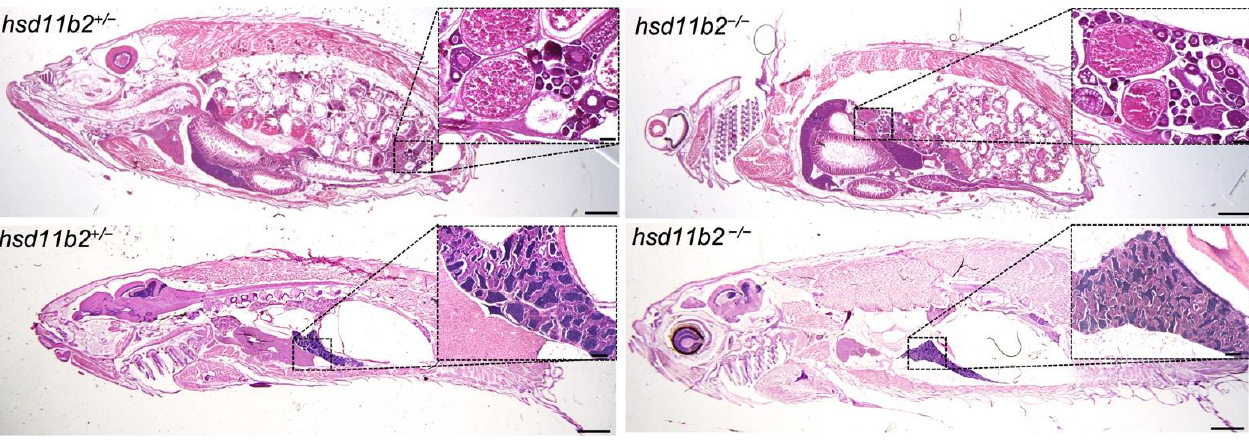
Figure 3. Histological analysis of 8-mpf female ( top panels ) and males ( bottom panels ) hsd11b2 +/− and hsd11b2 −/− zebrafish (scale bar = 1 mm). Magnification of ovaries ( top panels ) and testis ( bottom panels ) (scale bar = 100 um).